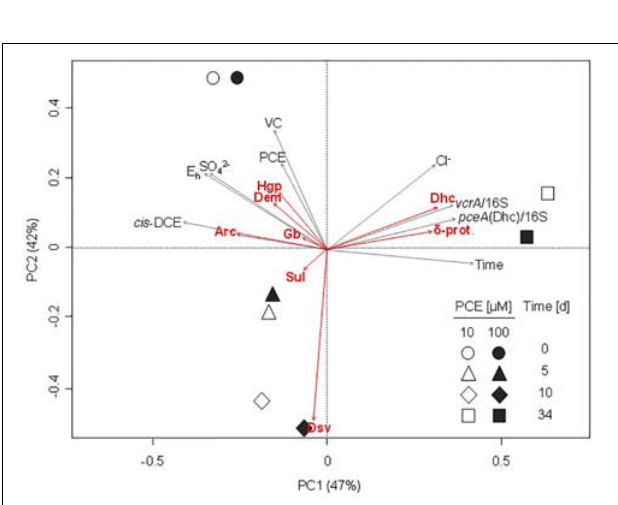
FIGURE 6 | Principal component analysis (PCA) ordination plot of bacterial communities during CEs dissipation. Largest contributions of bacterial taxa are represented by red arrows. Significant physico-chemical and biomolecular explanatory variables were fitted a posteriori on the PCA and are represented by gray arrows. Values on the axes indicate the percentage of the total variation explained by the corresponding axis (PC1, principal component axis 1; PC2, principal component axis 2). δ -prot., Deltaproteobacteria ; Arc, Arcobacter ; Dem, Dechloromonas ; Dhc, Dehalococcoides ; Dsv, Desulfovibrio ; Gb, Geobacter ; Hgp, Hydrogenophaga ; Sul, Sulfurospirillum